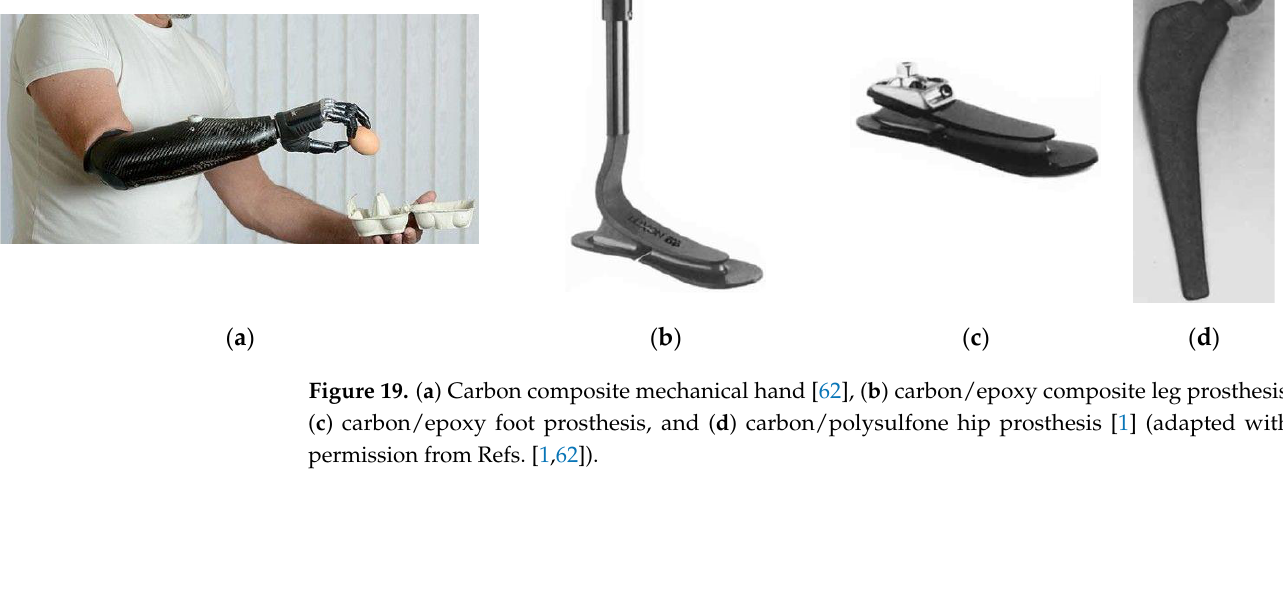
Figure 20. Carbon/epoxy composite bicycle frame weighing much less than the corresponding steel frame (reprinted with permission from Ref. [63]). 5. Challenges in Carbon Fibers Production The main obstacle in the production of carbon fibers is the high cost of precursors which includes more than 50% of the total cost of carbon fiber production [21]. The production of commercial-grade carbon fibers from pitch and PAN precursors is expensive due to the high cost of raw materials and complex processing steps with USD 15 – 20 per kg for pitch-based carbon fibers and USD 18 – 35 per kg for PAN-based carbon fibers [64]. Meanwhile, Kevlar and glass fibers cost, respectively, USD 23 and USD 2 per kg. It was also reported that PAN-based carbon fibers cost USD 35 per kg for use in the automotive industry [65]. If the cost of carbon fiber fabrication decreases to USD 11 per kg, carbon fiber-based automotive parts can be cost-competitive with steel-based automotive components with an average cost of USD 5 per kg. By using carbon fiber- reinforced composites in the automotive industry in the fabrication of automobile bodies, engine parts, transmission shafts, interior components, suspension systems, brakes, etc., the automobile manufacturing cost can be driven down by 80% due to a decrease in tooling and simpler manufacturing and assembling procedures as well as reducing the fuel consumption and cost by having a lighter weight automobile than a steel-based one. Using lightweight carbon fibers in batteries of electric vehicles could also be cost-effective by reducing the electricity consumption by cutting the weight of batteries where the lightest produced batteries by Tesla weigh over 450 kg [66]. To use carbon fibers in industrial applications, two essential criteria need to be considered: the cost (price per kilogram) and performance (mechanical/thermal/electrical